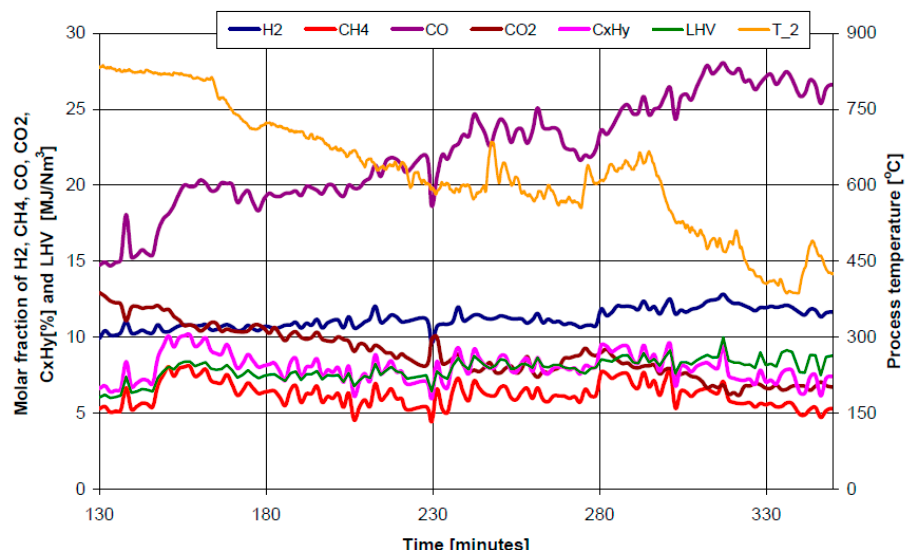
Figure 11. Composition, lower heating value and temperature of produced fuel gas in the gasification period of experiments.